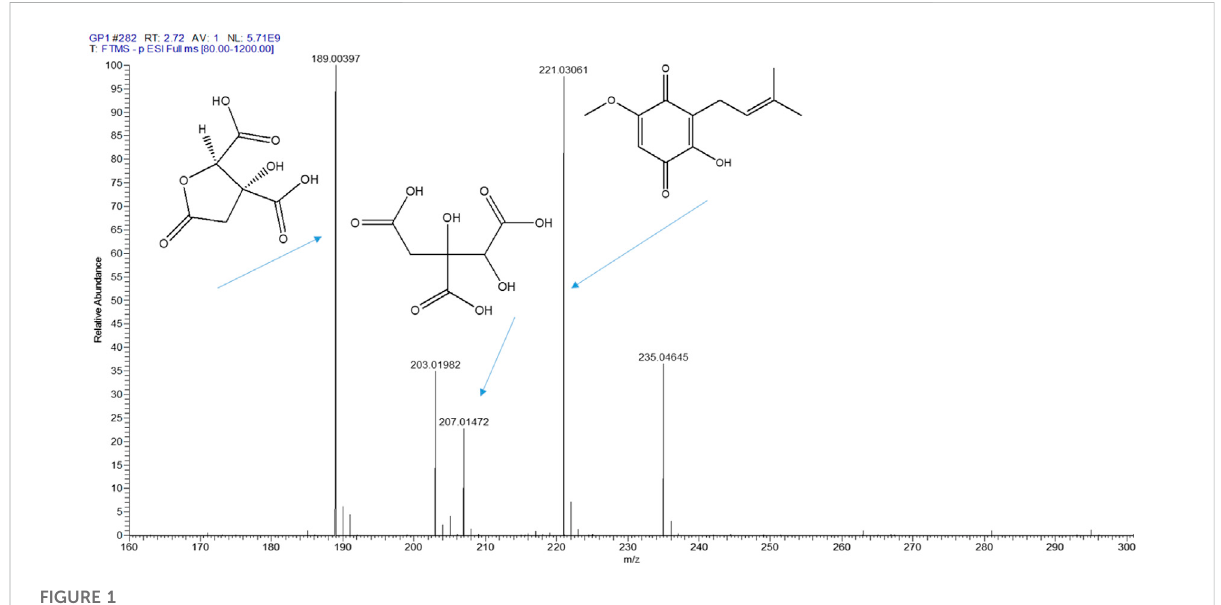
FIGURE 1 Identi fi cation of compounds from GP